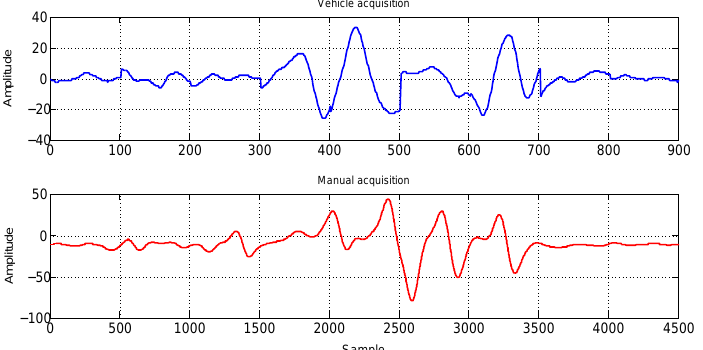
Figure 7. Comparison between manual ( top ) and vehicle acquisition ( bottom ). The signal behaviour is the similar for both acquisitions.